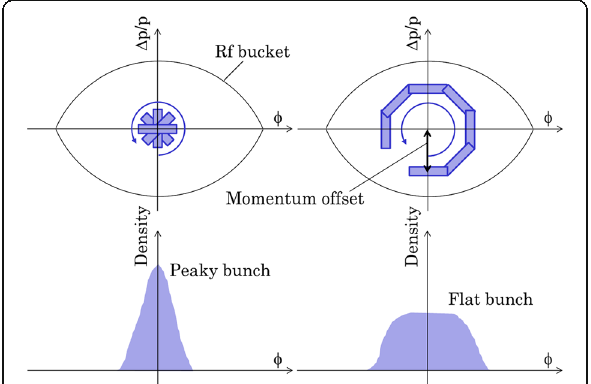
Fig. 15 Schematic diagram of the longitudinal motion for the multiturn injection process without (left) and with (right) a momentum offset, where the boxes represent the injection bunch train from the